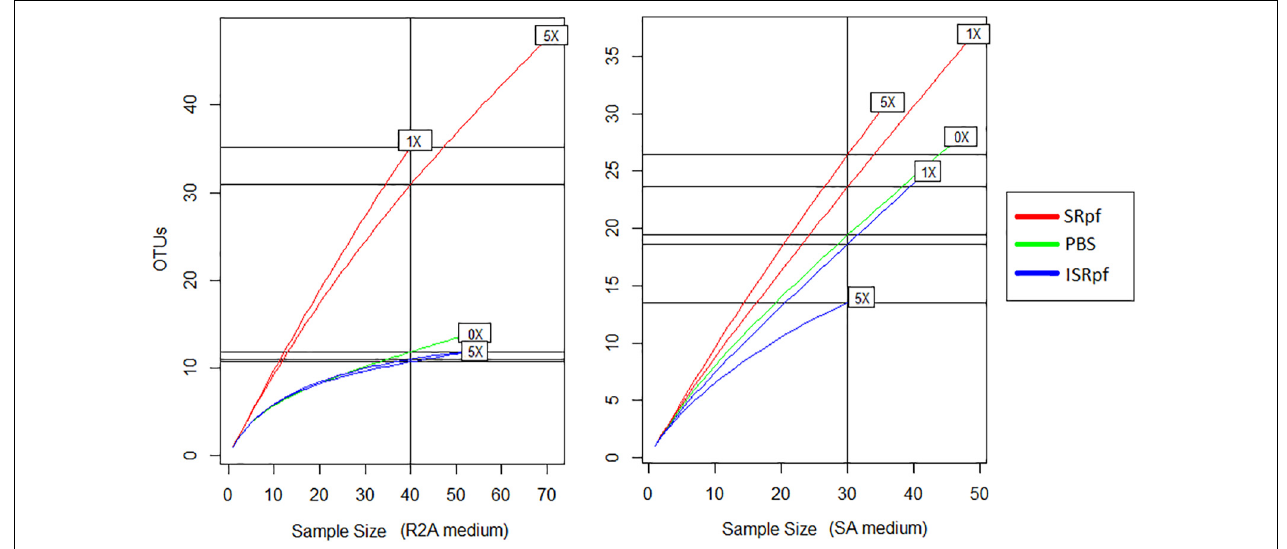
FIGURE 6 | Rarefaction curves of culturable fractions on R2A (left panel) and SA (right panel) for each treatment and concentration.